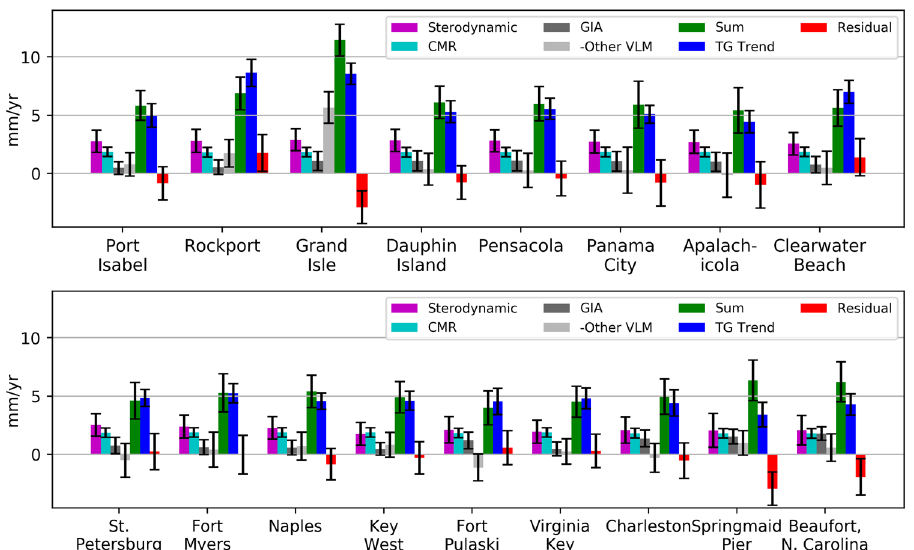
Fig. 6 Southeast and Gulf Coast sea level trends. Trend assessment from 1993 to 2018 for tide gauges along the U.S. southeast and Gulf coasts residuals are computed as the difference between the sum of the contemporary mass redistribution, sterodynamic effects, and GIA, and non-GIA vertical land motion components and the trend measured at the tide gauge. The vertical land motion component is inverted for interpretability. Uncertainty estimates represent two-standard